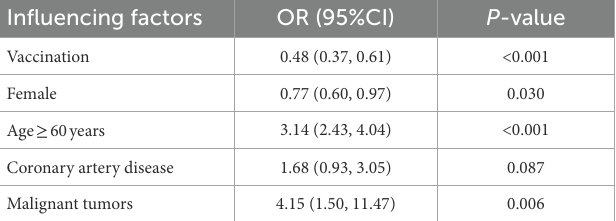
TABLE 5 Stepwise logistic regression analysis of the factors associated with moderate/severe illness in patients with symptomatic